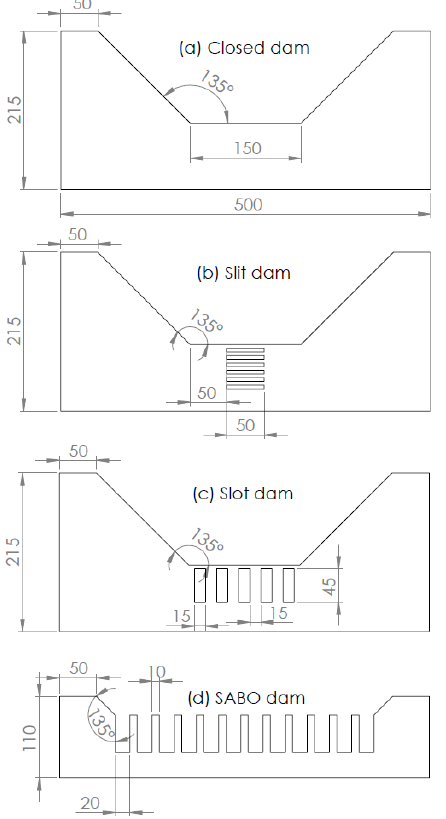
Figure 2. Dams tested: (a) closed dam, (b) grilled slit dam, (c) slot dam and (d) sabo dam.